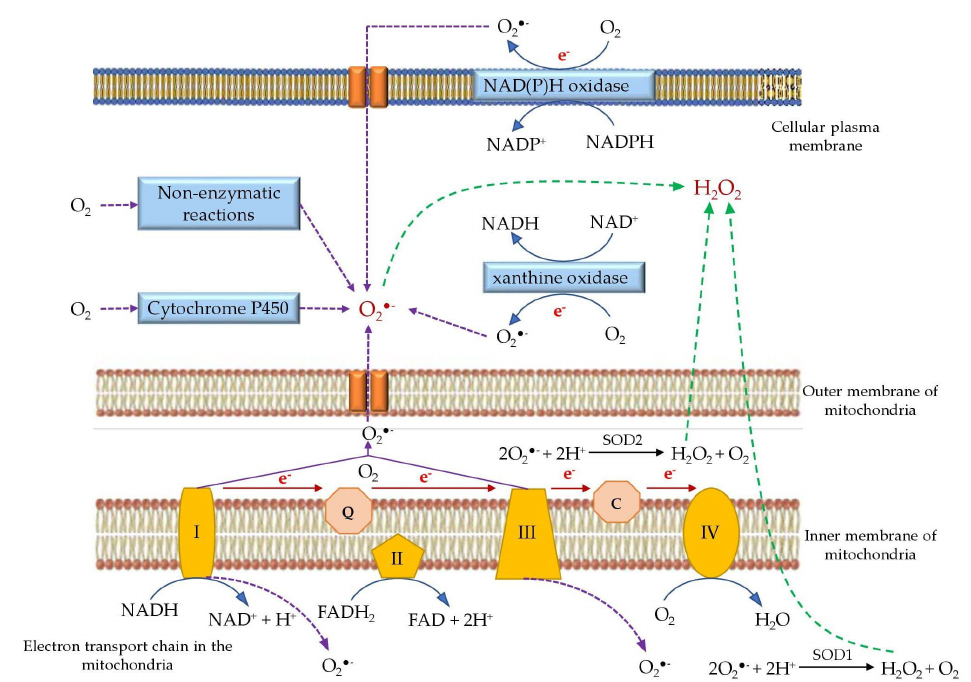
Figure 6. Generation of ROS in the mitochondria and cellular matrix of living organism. The